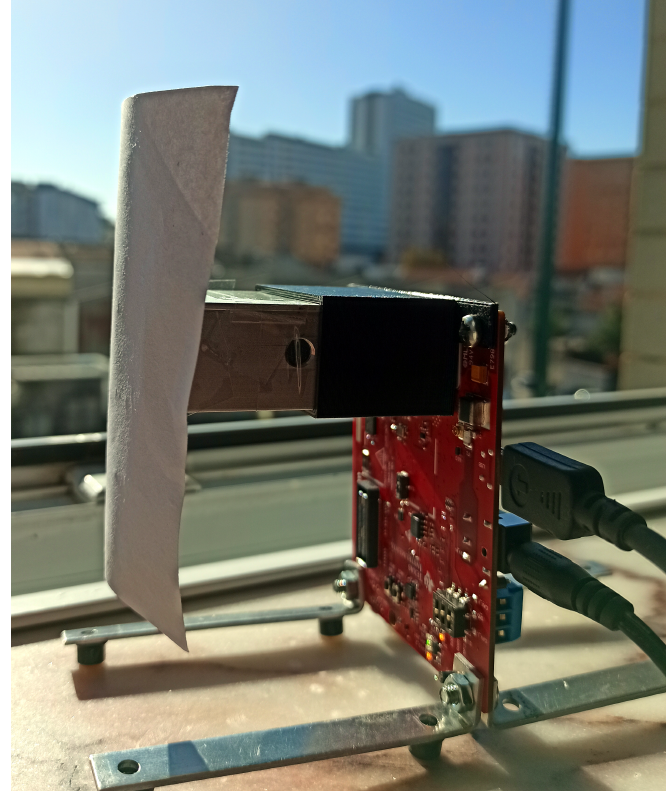
Figure 7. Radar setup to test sensibility to water. To perform the remaining tests, the radar antennas were headed to a plant’s leaf or stem. Two types of tests were considered: one approach consisted of collecting data for several hours. In the other method, while recording data from the radar, the plant was placed in a zone with direct solar exposition. Then, after a few minutes, we block the sunlight and remove this block after some time. The goal is to force a variation in the sap flow of the plant and verify the radar’s sensitivity to this change. The tests were performed on a kale’s stem and an Orchid leaf, as shown in Figure